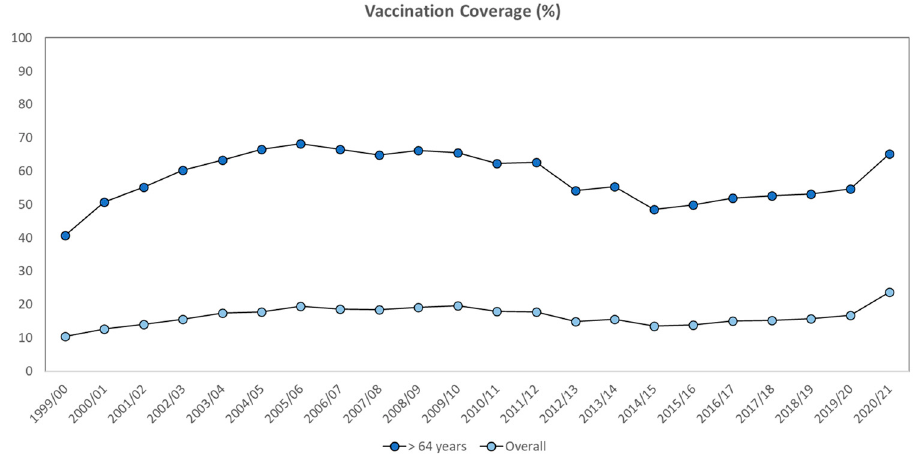
Figure 1. Influenza vaccination coverage in Italy from 2000 to 2021.